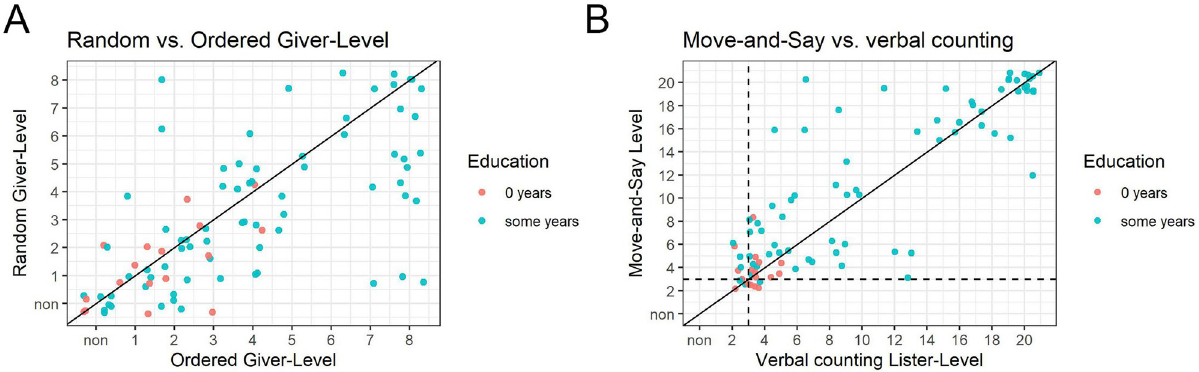
Fig 6. Task differences. Scatter plots showing performance of individuals on different tasks related to counting. Dots represent individual subjects and are jittered to prevent overlap. Participants are color-coded by education.